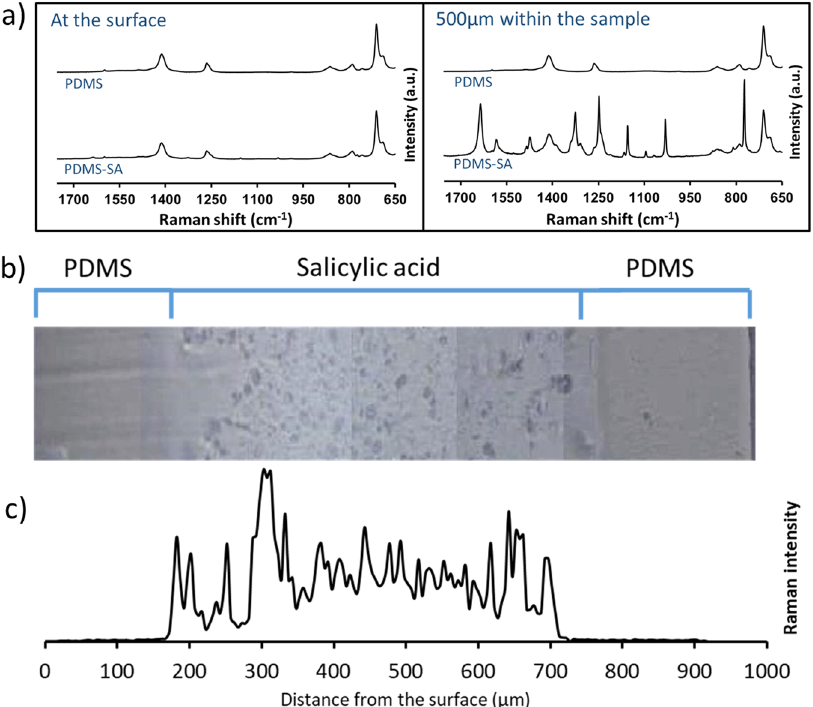
Fig. 3 Spatially resolved Raman spectroscopy of PDMS and PDMS-SA. a comparison of Raman spectra at the surface and at 500 µm within the sample; b Optical image of the cross section of a representative PDMS-SA sample; c Raman intensity of SA peak at 1032 cm − 1 along the cross-section of PDMS-SA.